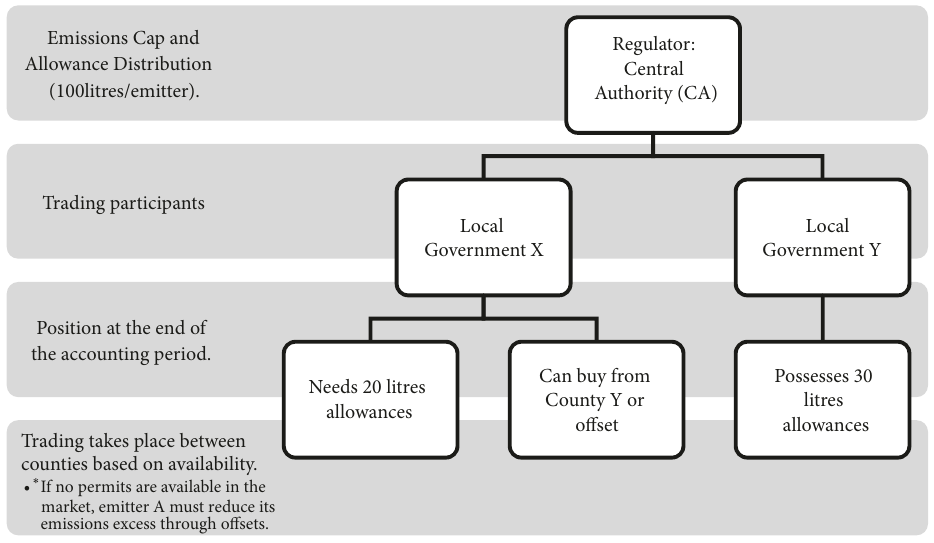
Figure 5: Local government X and Y’s trading